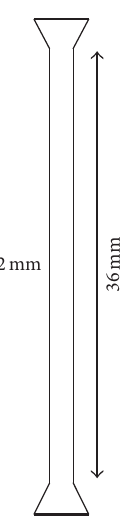
Figure 1: Scalloping of the outermost gastrocnemius tendon. The midsection of gastrocnemius tendon was cut as shown to create a predetermined region for measuring tendon failure.